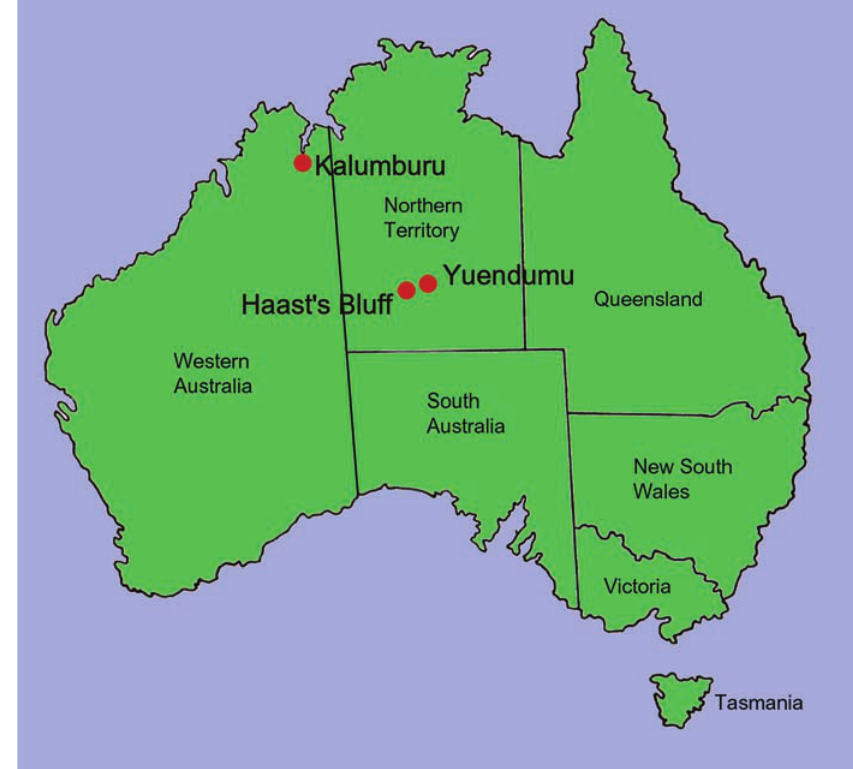
Figure 5 Map of Australia showing locations of Yuendumu and Haast’s